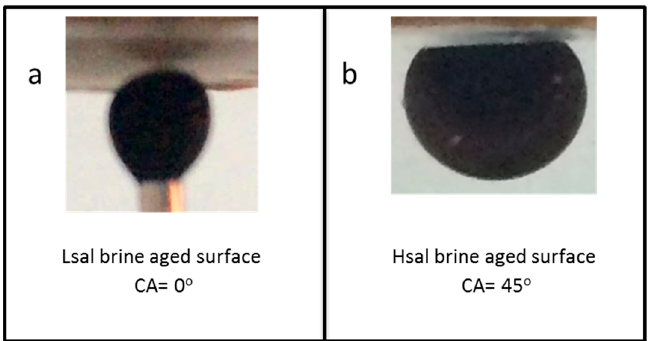
Figure 5. Images of pendant oil drops during the contact angle measurements of non-aged calcite in oil. ( a ) Cases 1 = strongly water wet and ( b ) Case 2 = preferentially water wet.